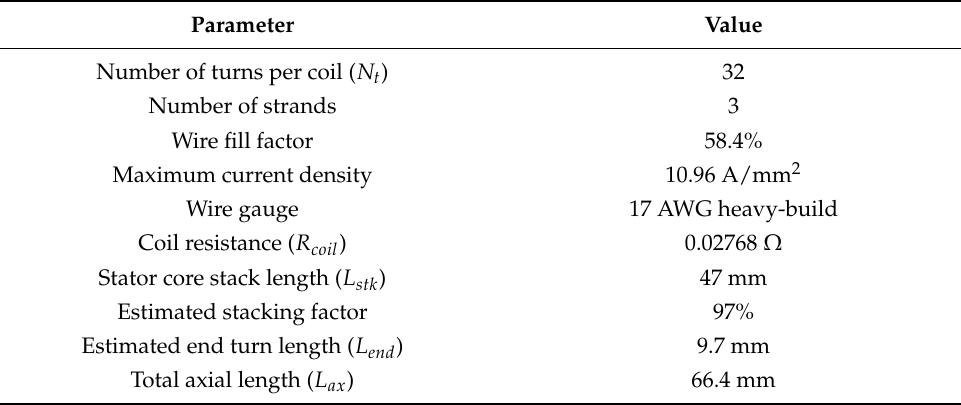
Table 6. Proposed winding configuration and axial length